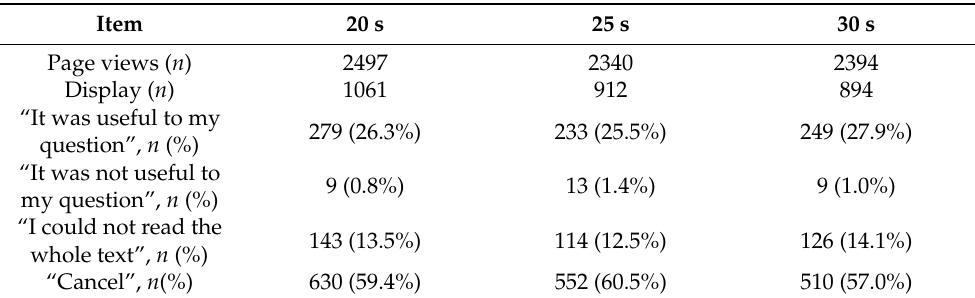
Table 4. Answers from viewers to the pop-up questionnaire for two days in the three groups relative to the timing of displaying the pop-up